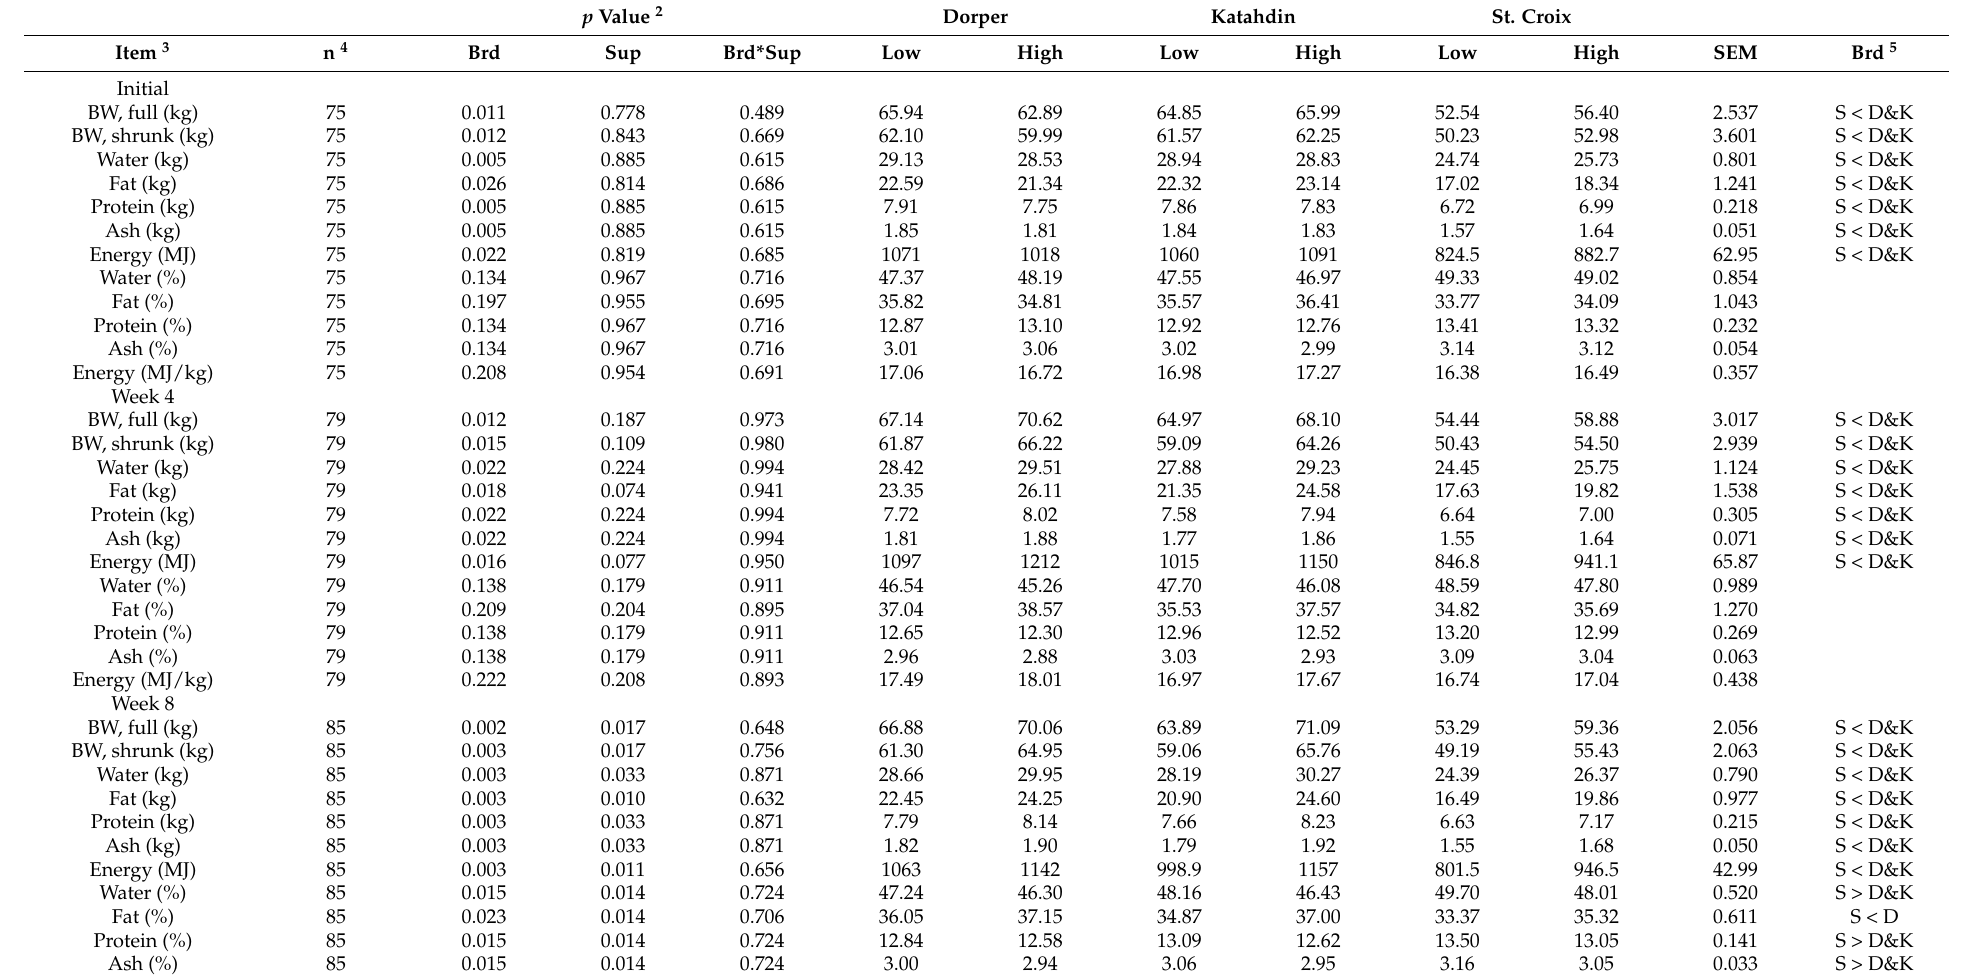
Table 3. Effects of breed and supplementation treatment on body weight and body composition of hair sheep based on urea space measures 1 . p Value